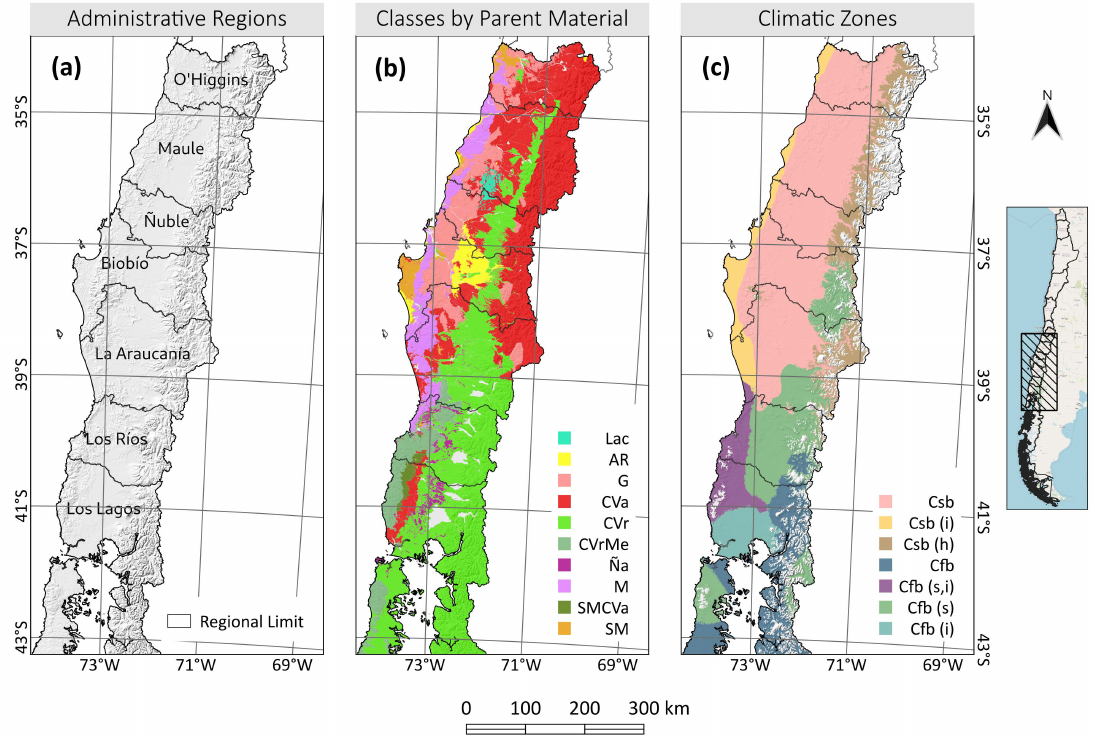
Figure 3. Categorical layers used to characterize the spatial variability of the Carbon pools: ( a ) Administrative regions; ( b ) Soil classes by parent material: soils formed over lacustrine parent material (Lac), soils formed from sandy alluvial deposits (AR); soils formed from granitic materials (G); soils formed from old volcanic ash deposits (CVa); soils formed from recent volcanic ash deposits (CVr); soils formed from recent volcanic ash deposits over metamorphic materials (CVrMe); Ñadis soils (Ña); soils formed over metamorphic parent material (M); soils formed over marine sediments covered by old volcanic ash (SMCVa) and, soils formed over marine sediments (SM); ( c ) Climatic zones: Mediterranean warm/cool summer climates were divided in 3 classes: Mediterranean warm/cool summer climate (Csb), Mediterranean warm/cool summer climate with a more pronounced coastal influence (Csb(i)) and Mediterranean warm/cool summer climate from highlands (Csb(h)). Ocean climates were divided in 4 categories: Ocean climate (Cfb), Ocean climate with a more pronounced coastal influence and dry summer (Cfb(s,i)), Ocean climate with a dry summer (Cfb(s)) and Ocean climate with a more pronounced oceanic influence